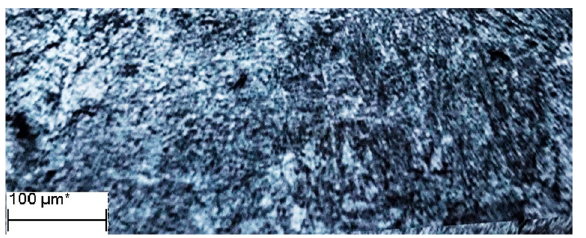
Figure 4. The structure of the base metal of the welded joint from the steel 25H2NMFA. ×400. *—mkm.